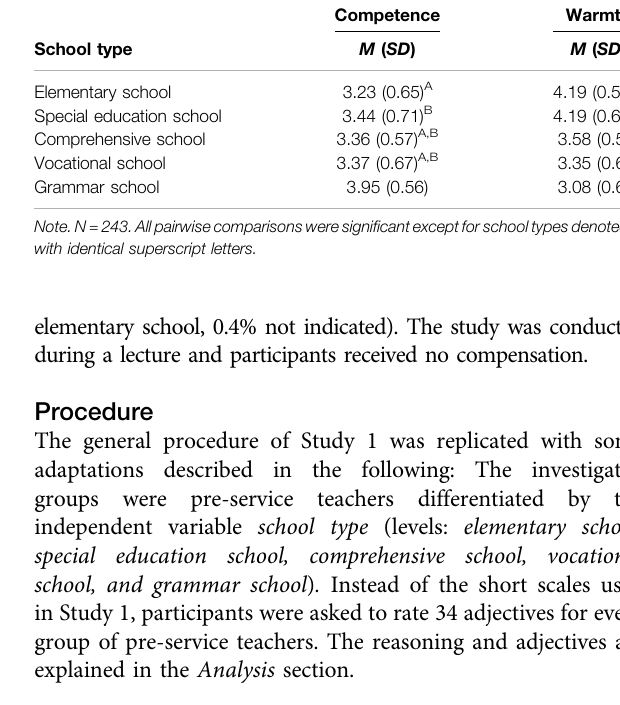
TABLE 2 | Competence and warmth ratings of pre-service teachers for different school types in Study 2.